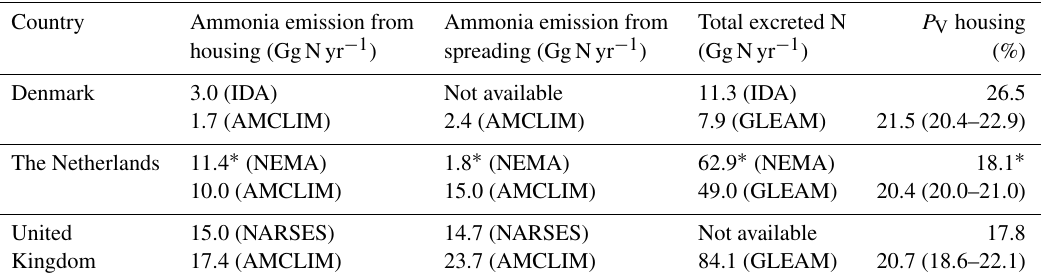
Table 2. Estimates of NH 3 emissions from poultry/chicken farming by the Integrated Database model for Agricultural emissions (IDA; Albrektsen et al., 2017) for Denmark, by the National Ammonia Reduction Strategy Evaluation System (NARSES; Misselbrook et al., 2011) for the United Kingdom, based on 2010 values, and by the National Emission Model for Ammonia (NEMA; Velthof et al., 2012) for the Netherlands, based on 2009 ∗ values. Ranges given in the P V housing represent the geographical variations across the